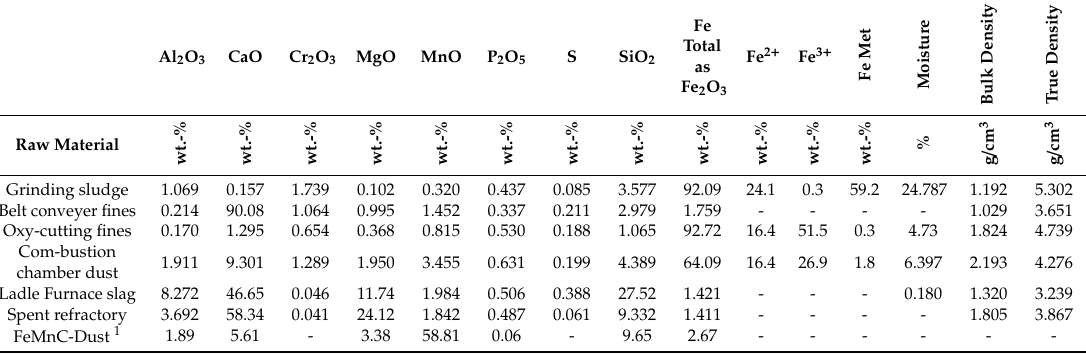
Table 1. Main components and physical properties of the electric arc furnace (EAF)